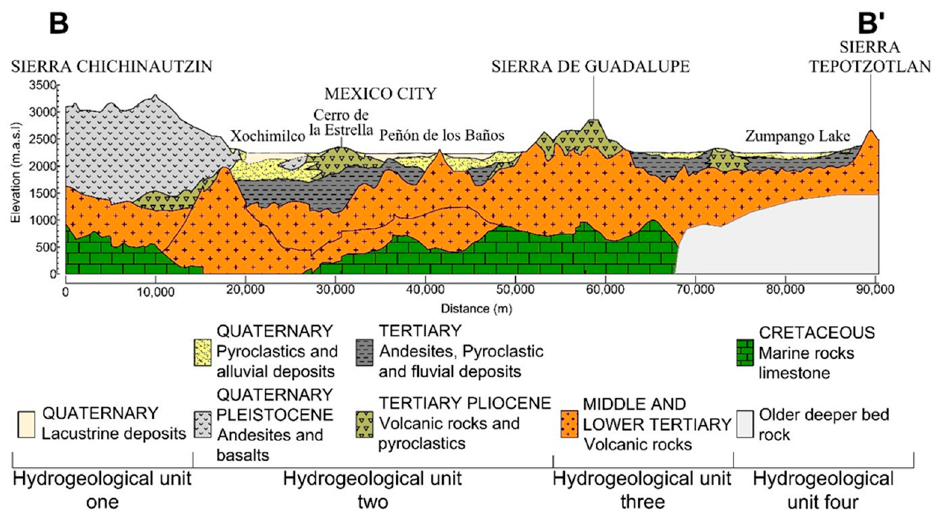
Figure 7. South-north geological cross section of the MB modified after [3,10]; its location is shown in Figure 4 as B-B’.